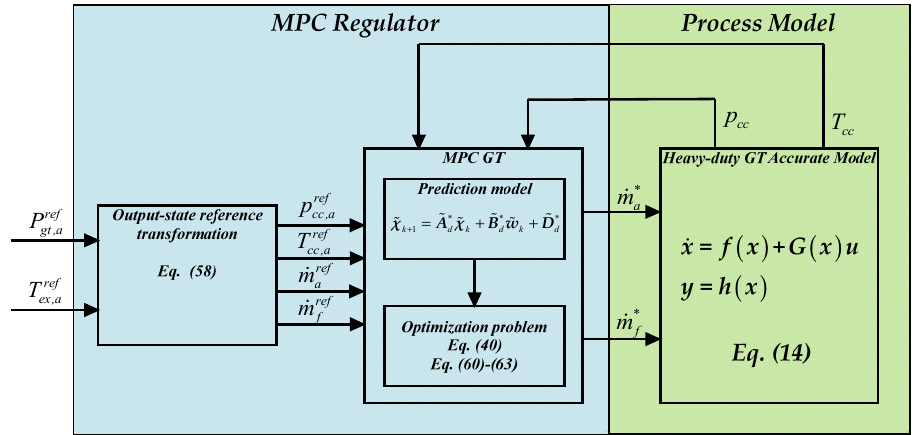
Figure 2. Heavy-duty GT model predictive control (MPC) block scheme.